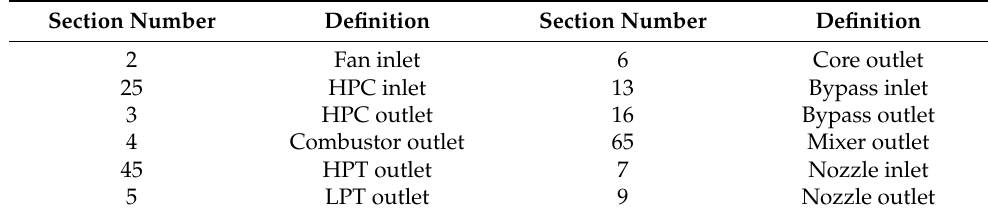
Table 1. Definition of engine section